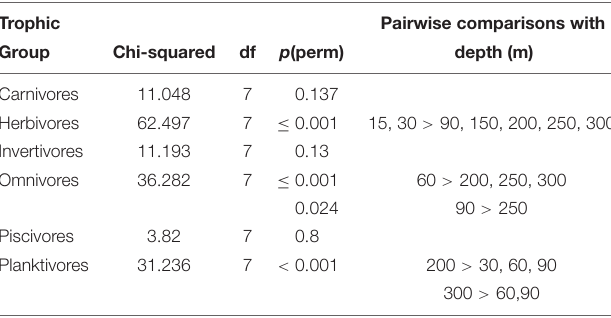
TABLE 2 | Comparison of relative fish trophic group biomass against depth using Kruskal-Wallis followed by Mann-Whitney pairwise comparisons. Trophic Pairwise comparisons with Group Chi-squared df p (perm)